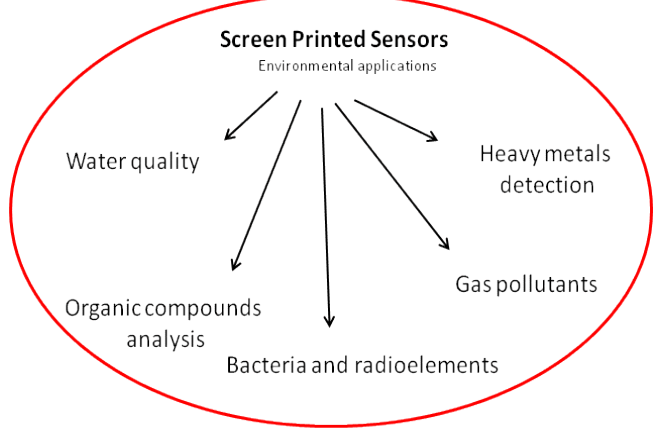
Figure 3. Potential environmental applications of screen printed